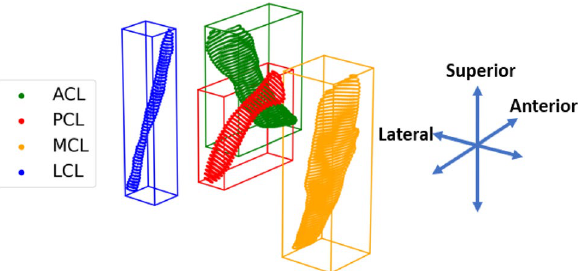
Figure 4. Estimating ligament stiffness from MRI. Cross-sections and the bounding box of each ligament surface mesh are presented. Multiple cross-sections are taken along the principal ligament axis derived by PCA. The ligament’s cross-sectional area is estimated as the mean of the areas of each